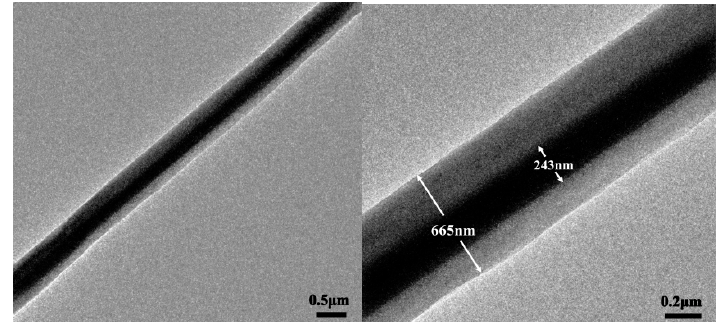
Figure 3. TEM observation of core-shell structure nanofiber containing emodin.